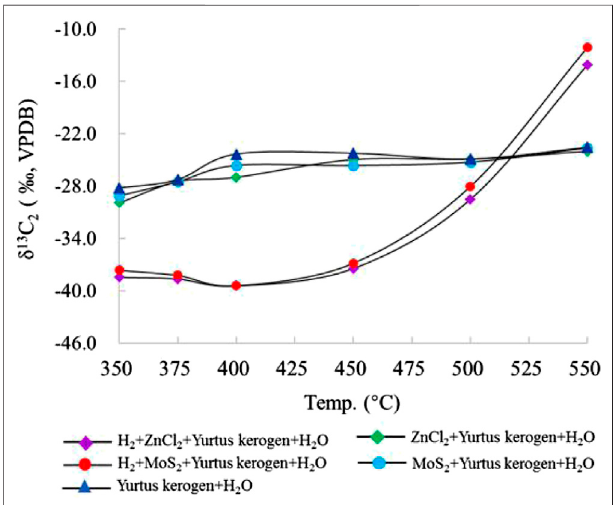
FIGURE 6 | Change in δ 13 C 2 simulated under different catalytic hydrogenation control conditions of the closed system.